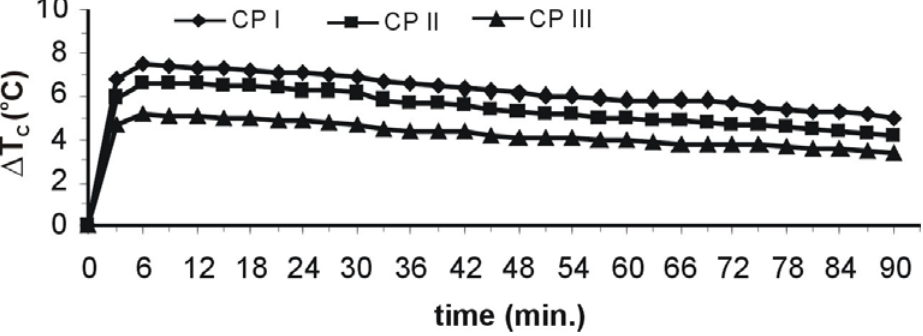
Figure 2. The variation of the temperature at the inlet and outlet of the condenser along the experiment according to the circulation pump flow rates at fixed waste water temperature of 20 °C.